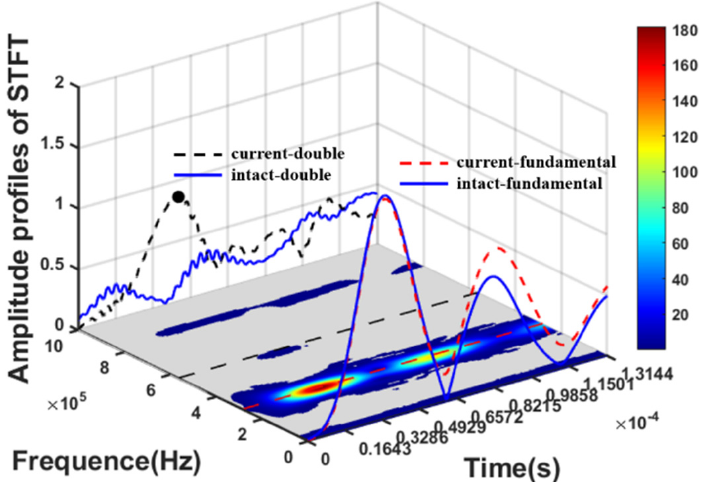
Figure 7. Spectrogram of the signals received from the sensing path AB in the current state, and amplitude profiles at the fundamental and double frequency for both the intact and the current state.